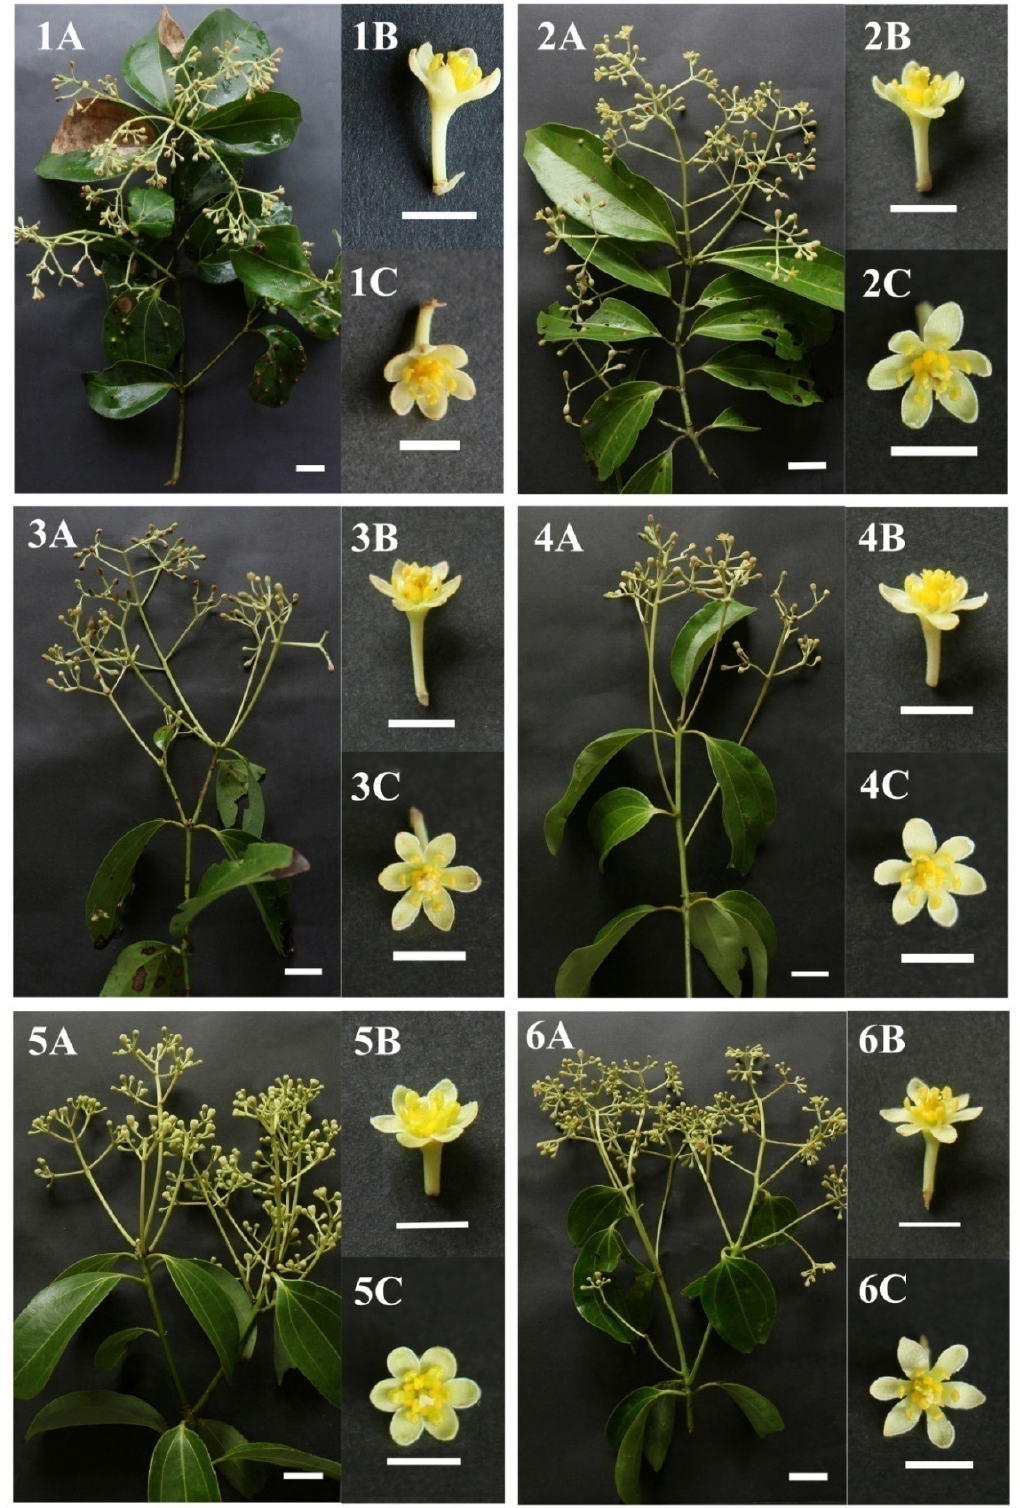
Figure 3: Inflorescence and single flower morphological variation in Cinnamomum verum. 1A, 1B & 1C. accession no. MKV–01 from cluster no. 2; 2A, 2B & 2C. accession no. MKR–03 from cluster no. 1; 3A, 3B & 3C. accession no. MMK–02 from cluster no. 4; 4A, 4B & 4C. accession no. MTK–03 from cluster no. 4; 5A, 5B & 5C. accession no. MKD–01 from cluster no. 3; 6A, 6B & 6C. accession no. MKD–02 from cluster no. 3. (A= Inflorescence, Scale bar = 2 cm; B= Longitudinal view of single flower, Scale bar = 5 mm; C= Front view of single flower, Scale bar =